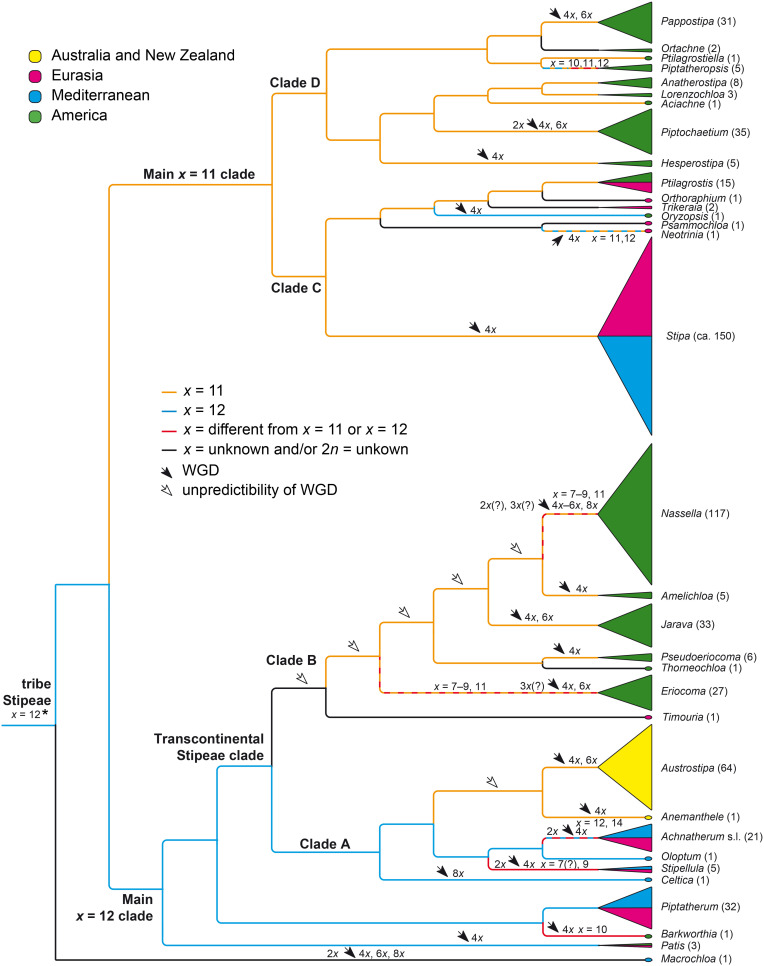
Chromosome base numbers, dysploidy and whole-genome duplications in the evolution of tribe Stipeae mapped on a simplified molecular phylogenetic tree with the genera of Stipeae and their approximate sizes. The cladogram is modified from the plastid DNA tree of Romaschenko et al. (2012) and the plastid/nuclear DNA tree (concatenated data of congruent taxa) of Hamasha et al. (2012). The treatment of genera and estimated number of species largely follows Peterson et al. (2019). For chromosome data see Supplementary Appendix 2. The species number of a genus is indicated after the genus name. Due to the unknown chromosome numbers in Thorneochloa and Timouria it is unclear at which split in Clade B whole-genome duplications occurred, potentially already in the common ancestor of all Clade B taxa (open arrows). The asterisk denotes our suggested most likely chromosome base number (see section “Discussion”). WGD, whole-genome duplication.